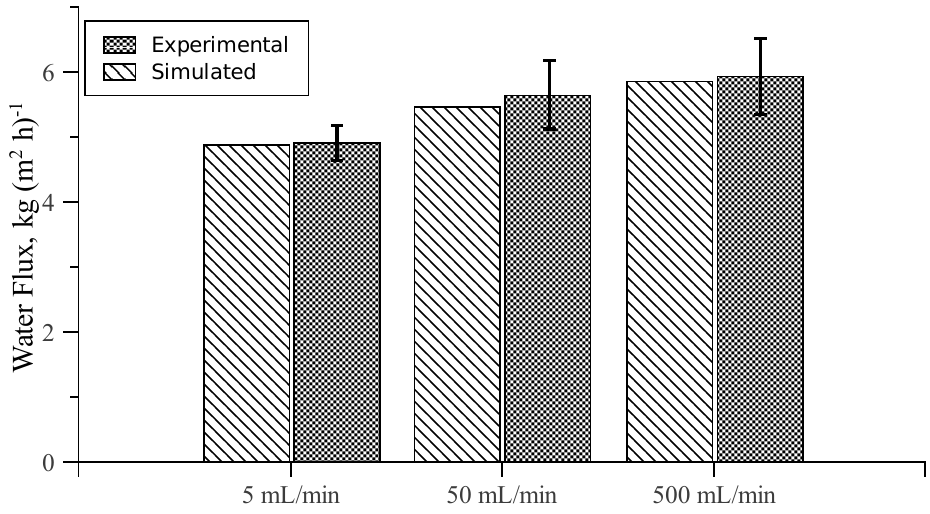
Figure 3. Experimental and numerical results for water fluxes in chamber A at different cross-flow velocities. In all experiments a 1 M draw solution and a pure water feed solution was